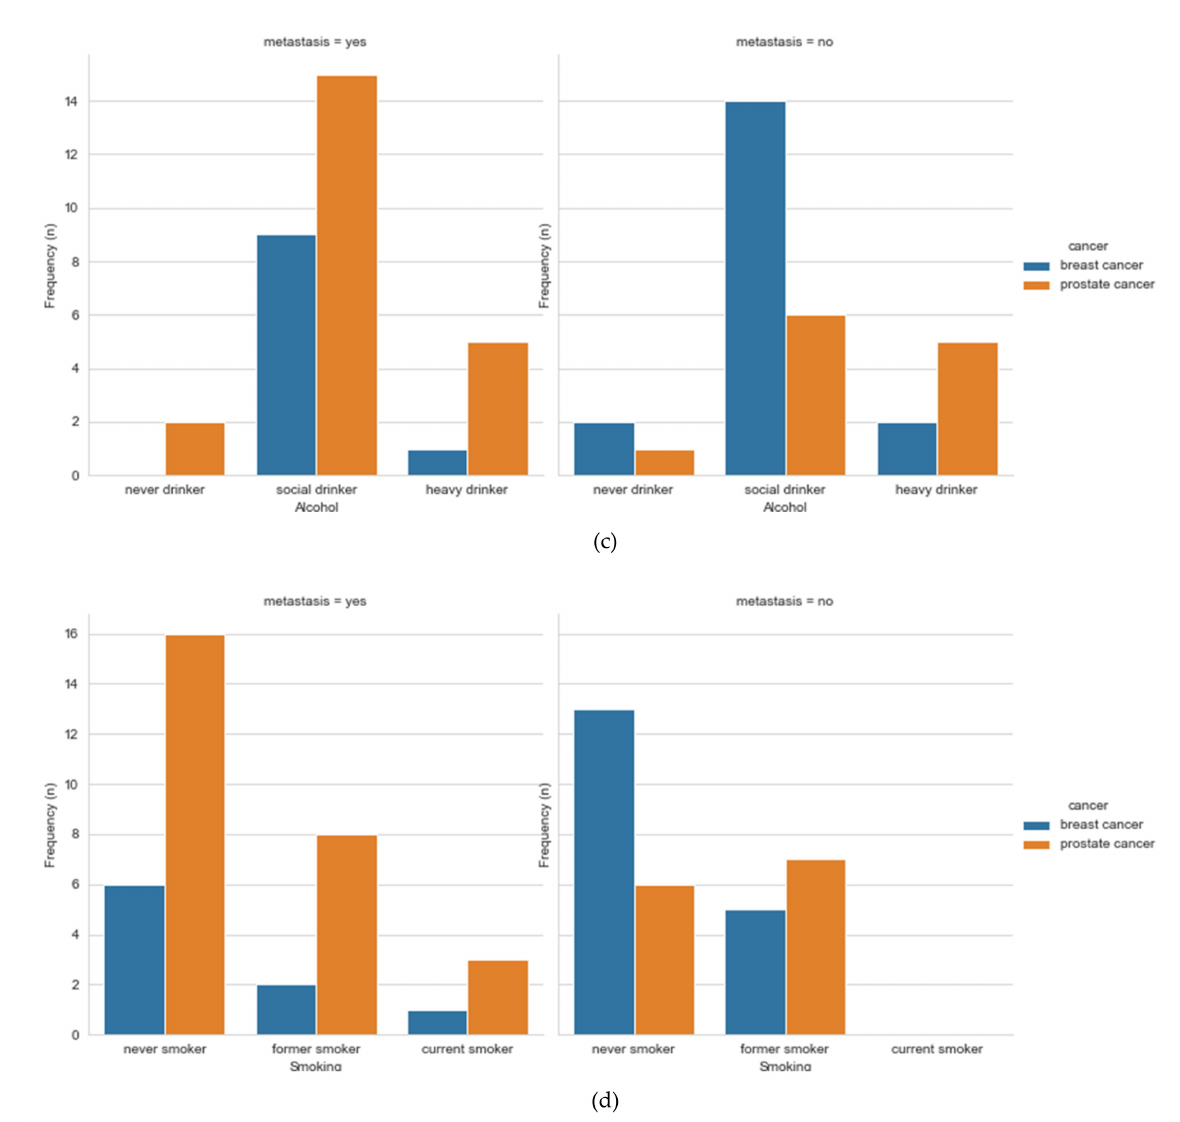
Figure 2. Population graphs for BCa and PCa diet ( a ), exercise ( b ), alcohol ( c ), and smoking ( d ) for metastatic and non-metastatic disease.